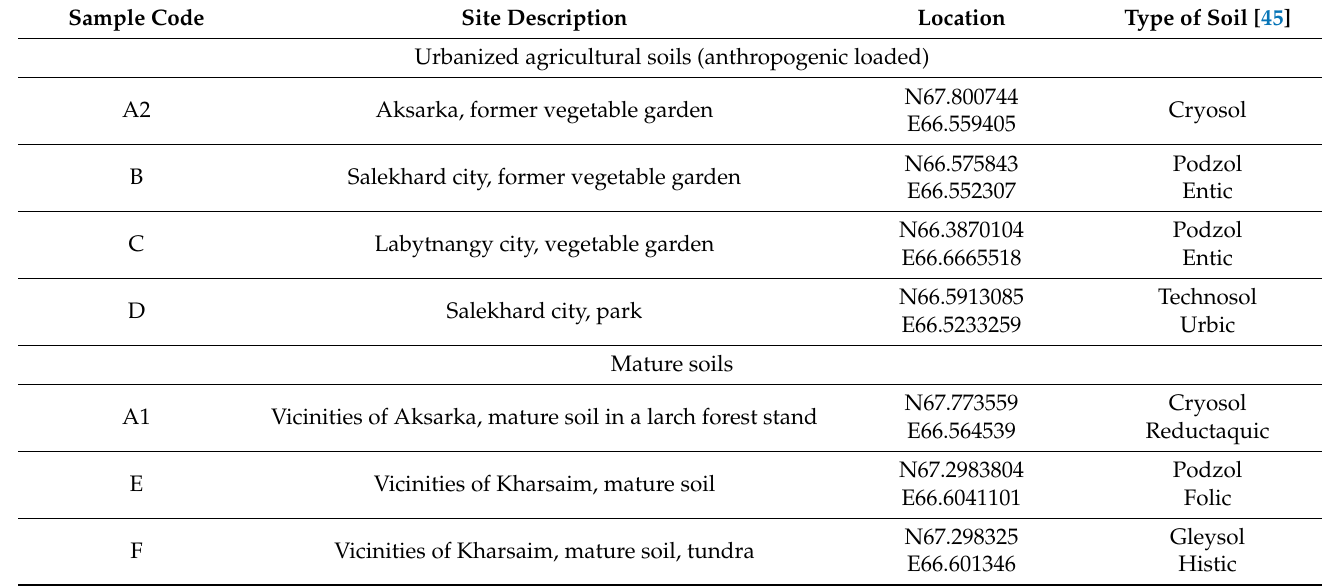
Table 1. Site descriptions and soil types of each sampling